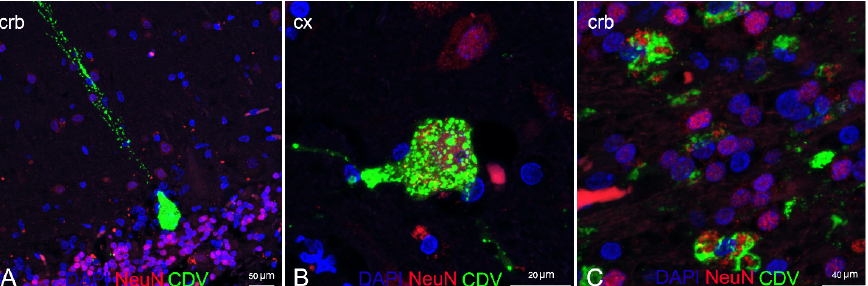
Figure 7. Characterization of DMV CNS infection by means of double IF for neurons and DMV. ( A ) Cerebellar cortex (ID 28) Purkenje cell positive for positive for DMV. ( B ) Cerebral cortex (ID 28). Cortical neuron positive for DMV. ( C ) Cerebellar cortex (ID 10). Neurons of granular layer positive for DMV. Legend: Cx, cortex; Crb, cerebellum; DAPI, 4,6-diamidino-2-phenylindole; DMV, dolphin morbillivirus; CDV, canine distemper virus.